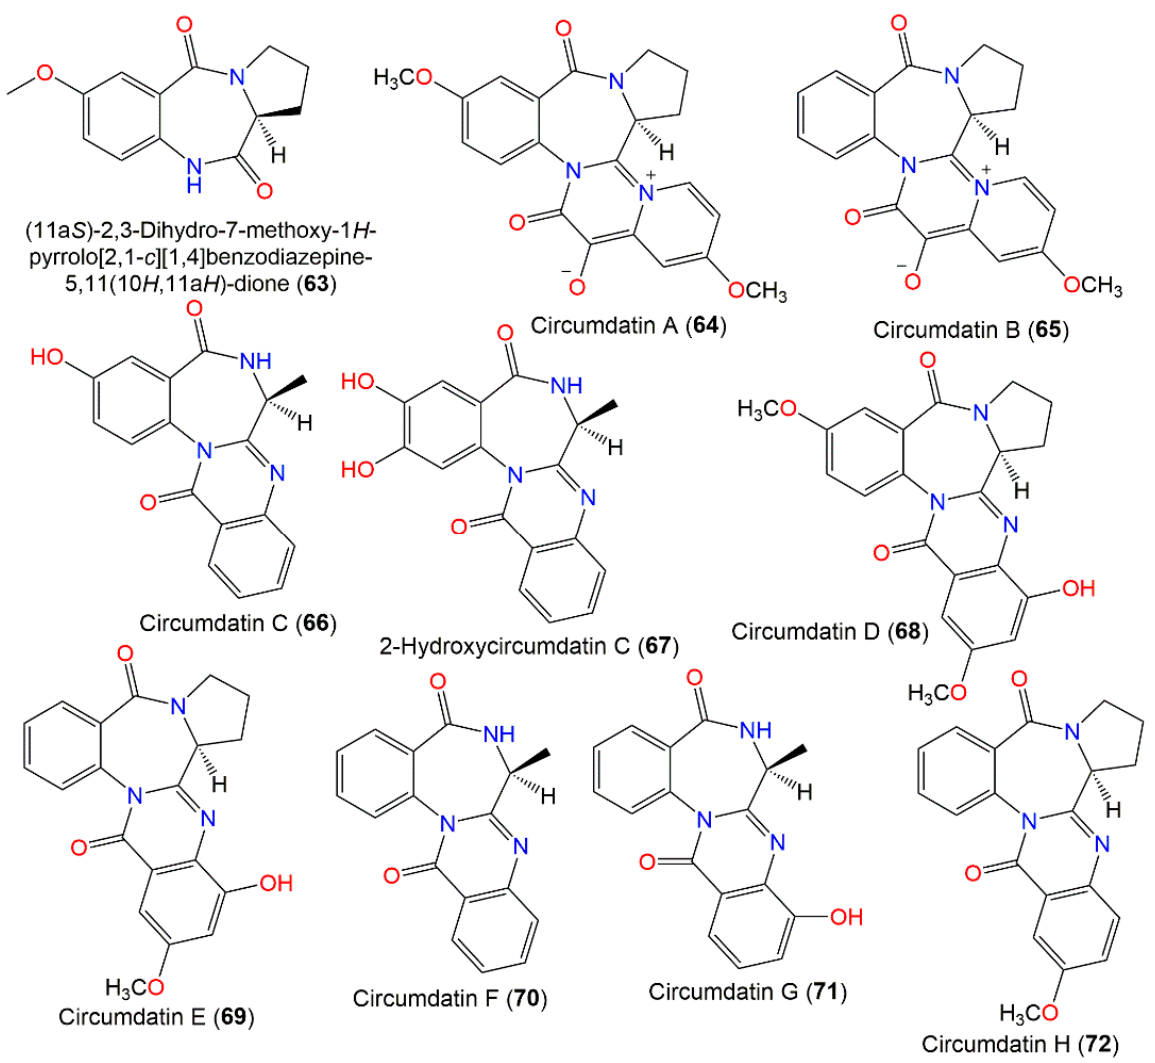
Figure 6. Benzodiazepine derivatives ( 63 – 72 ) reported from A. ochraceus.